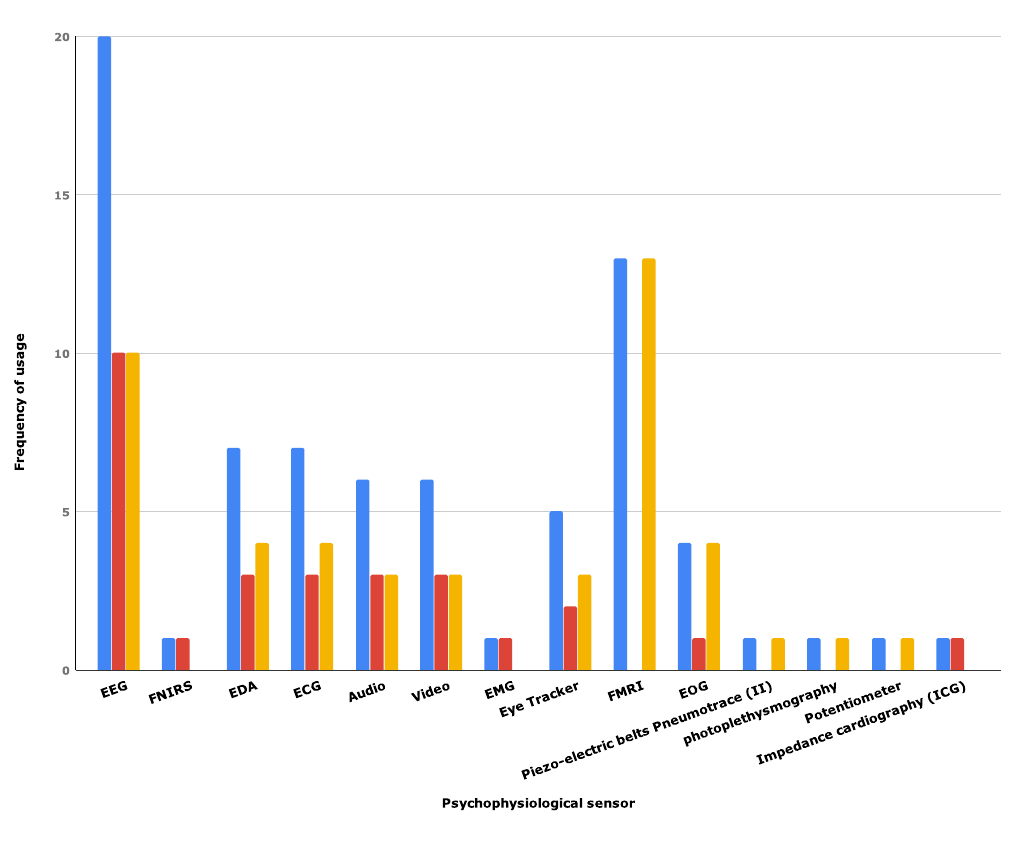
Figure 5. (1) Psychophysiological signal usage frequency study for study and context (trust in technology and interpersonal